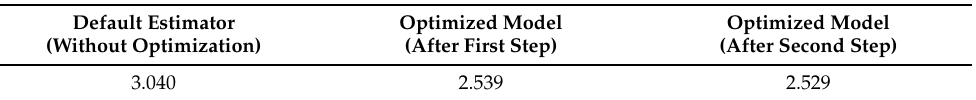
Table 5. Comparison of the MAE obtained using the default model with respect to that obtained after the first and second steps of the optimization phase.